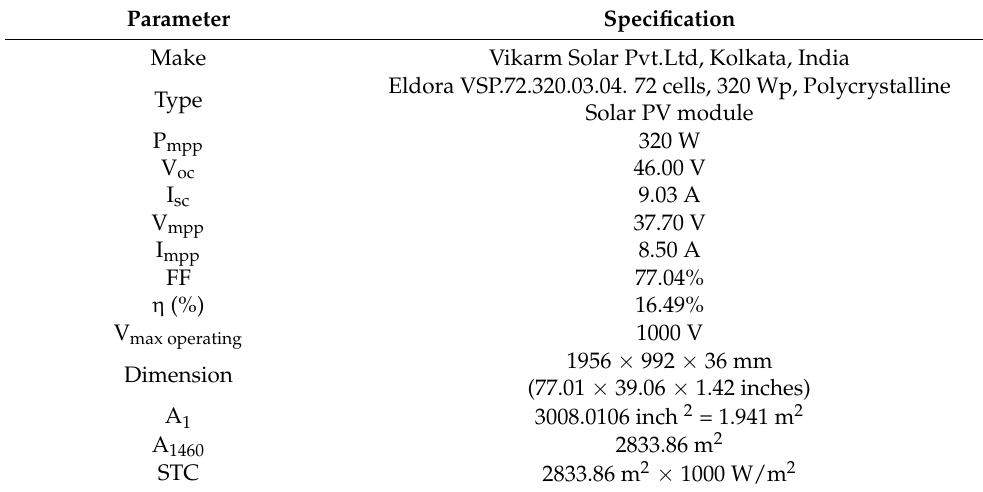
Table 3. Detailed Specification of the solar panels used at the